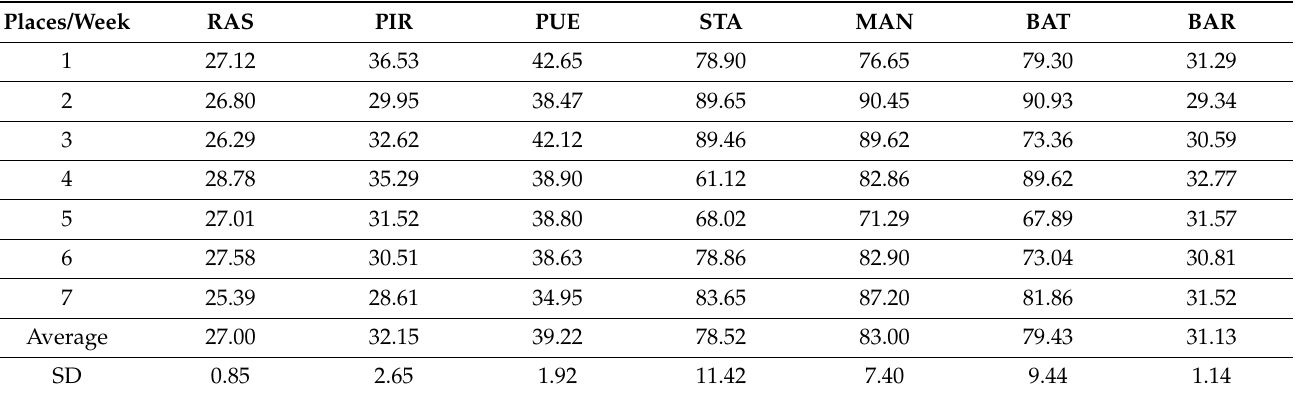
Table 6. WQI for different sampled